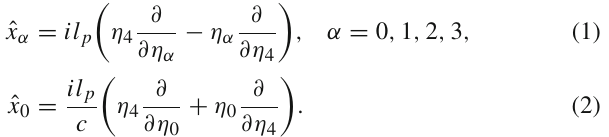
are present. Fundamental to this notion is the presence of closed triples, or triangles, in the graph. In Fig. 1. we